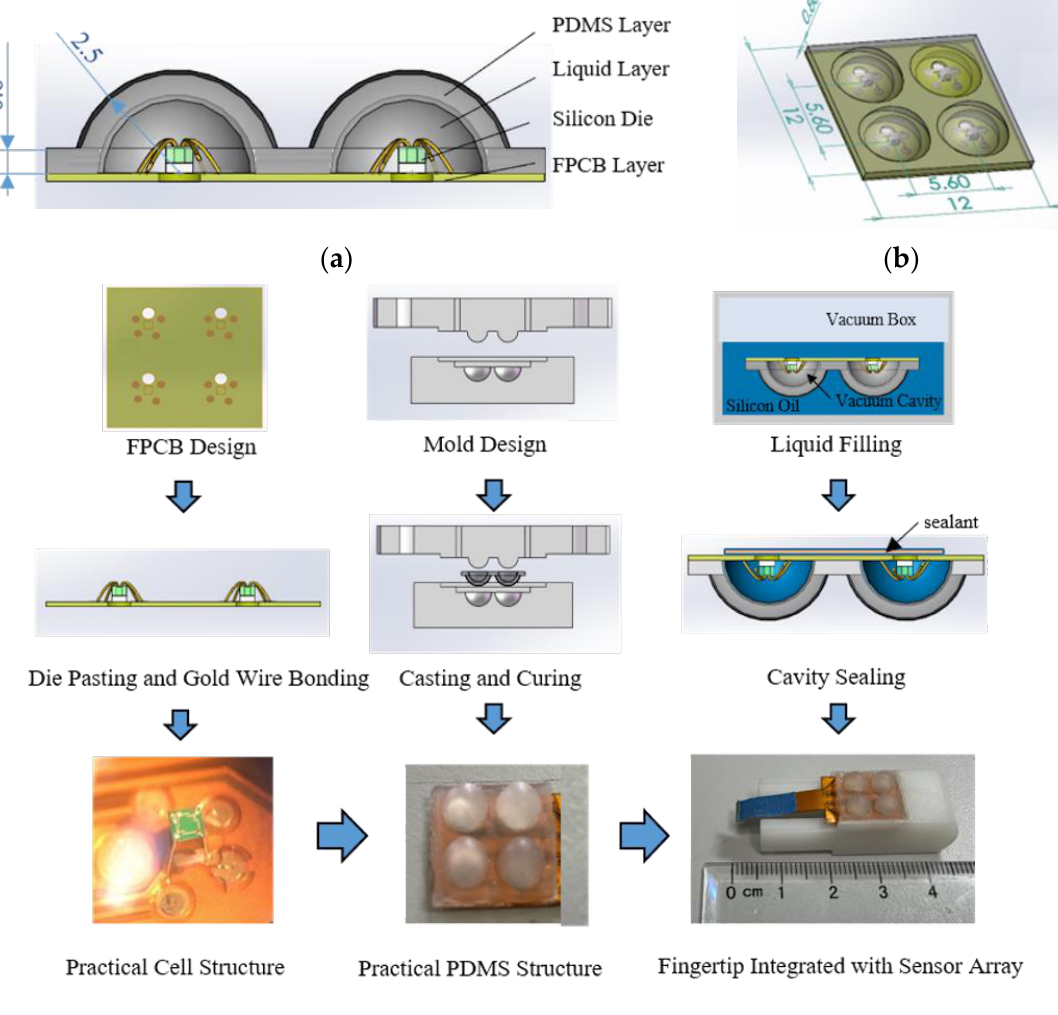
Figure 1. Schematic diagram of sloid–liquid composite tactile sensor array structure: ( a ) cross-section diagram of the sensing cell structure; ( b ) diagram of the whole tactile sensor array; ( c ) flow diagram of sensor fabrication